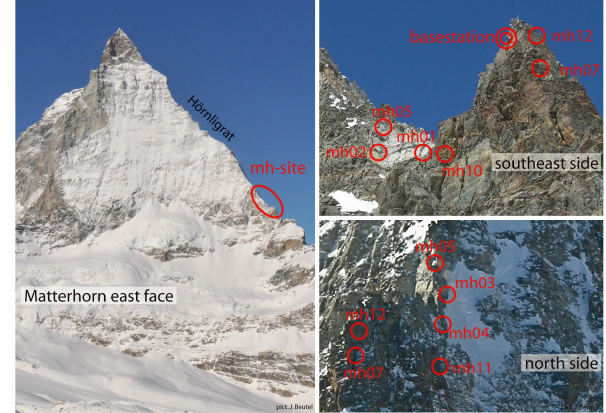
Fig. 4. Close-up of sensors in densly fractured rock at the south side of Sphinx, Jungfraujoch. The picture is taken in April 2007 after a periode with intense